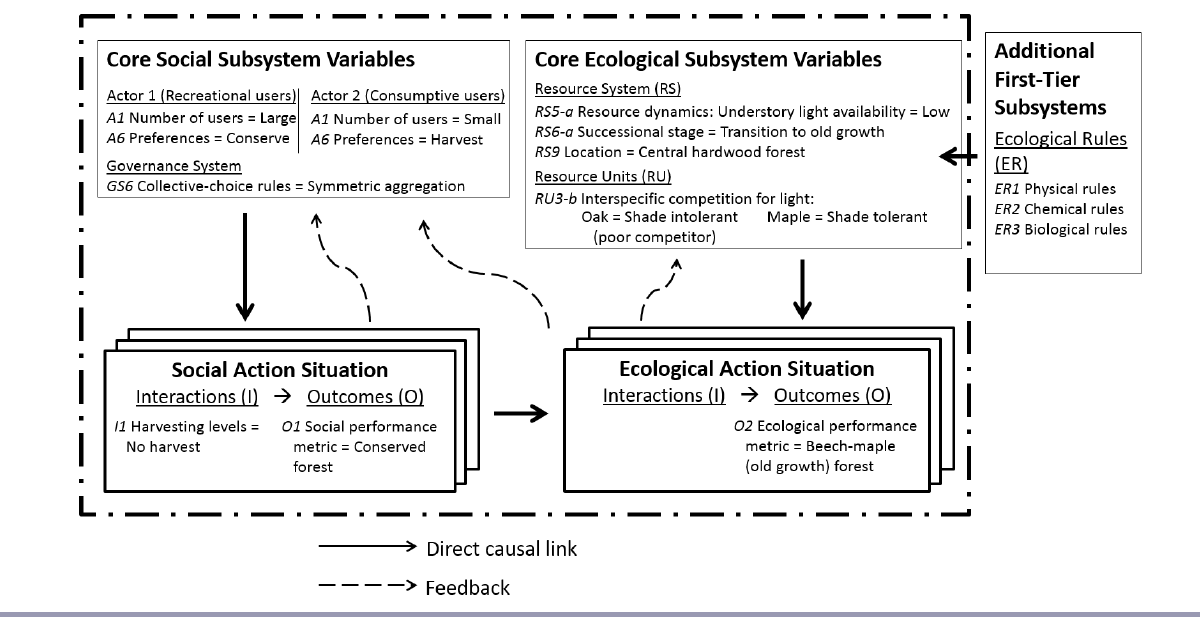
Fig. 2 . Application of a modified social-ecological system framework to Yellowwood Lake Watershed forest. Interactions and outcomes are part of an iterative process that feeds back into the Core Subsystems (RS, RU, GS, A) to shape both the social and biophysical